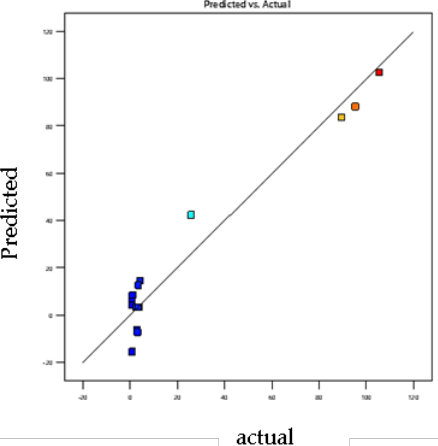
Figure 6. Plot of predicted value vs. observed value for BA elution efficiencies. Y Predicted p < 0.023; R 2 adjusted = 0.98; R 2 predicted = 0.92.